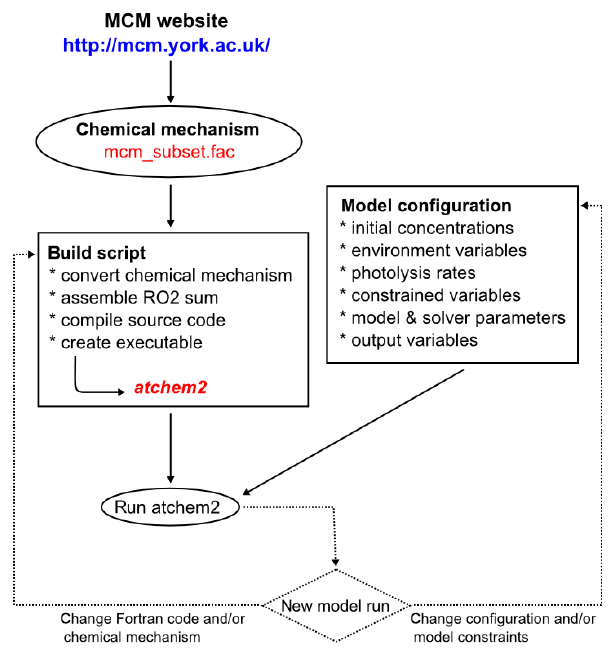
Figure 5. Workflow of the AtChem2